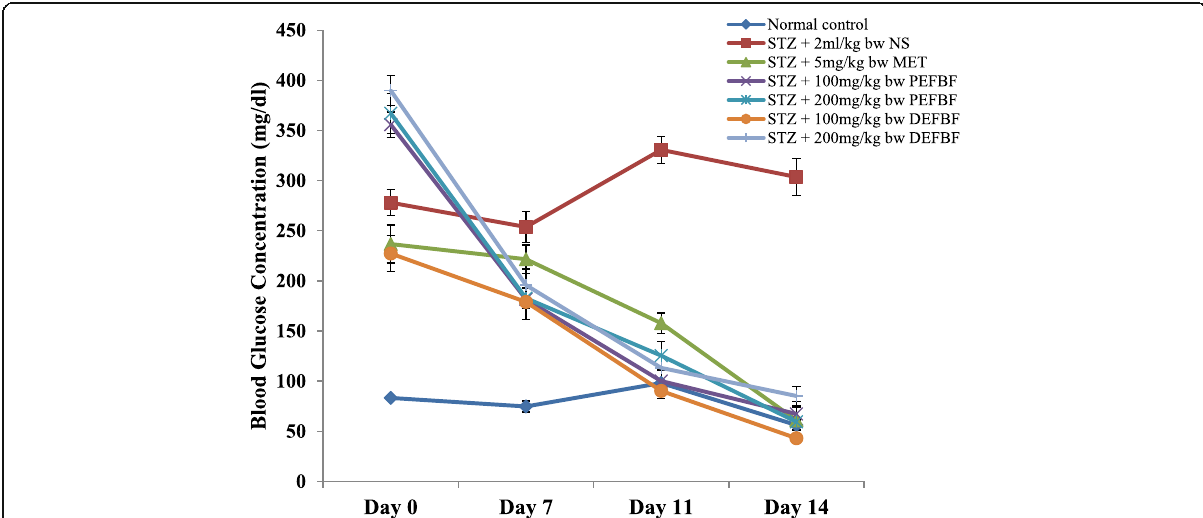
Fig. 3 Effect of petroleum and diethyl ether fractions of Bridelia ferruginea Benth on Blood Glucose Level. NS: Normal saline; MET: Metformin; PEFBF: Petroleum ether fraction of Bridelia ferruginea ; DEFBF: diethyl ether fraction of Bridelia